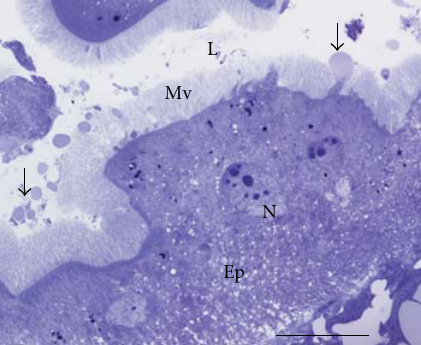
Figure 25: Detail of a N. abietis larva salivary gland anterior duct showing the nucleus (N) and microvilli (Mv) of epithelial cells (Ep) and secretory products (arrows) in the lumen (L) of the duct. Scale bar = 30 μ